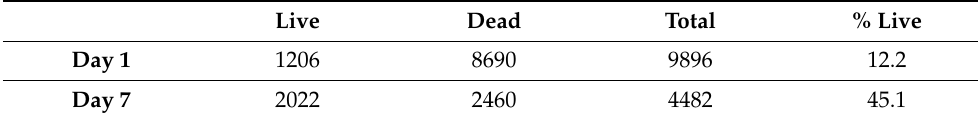
Table 1. Analysis of live and dead cells at day 1 and day 7 post